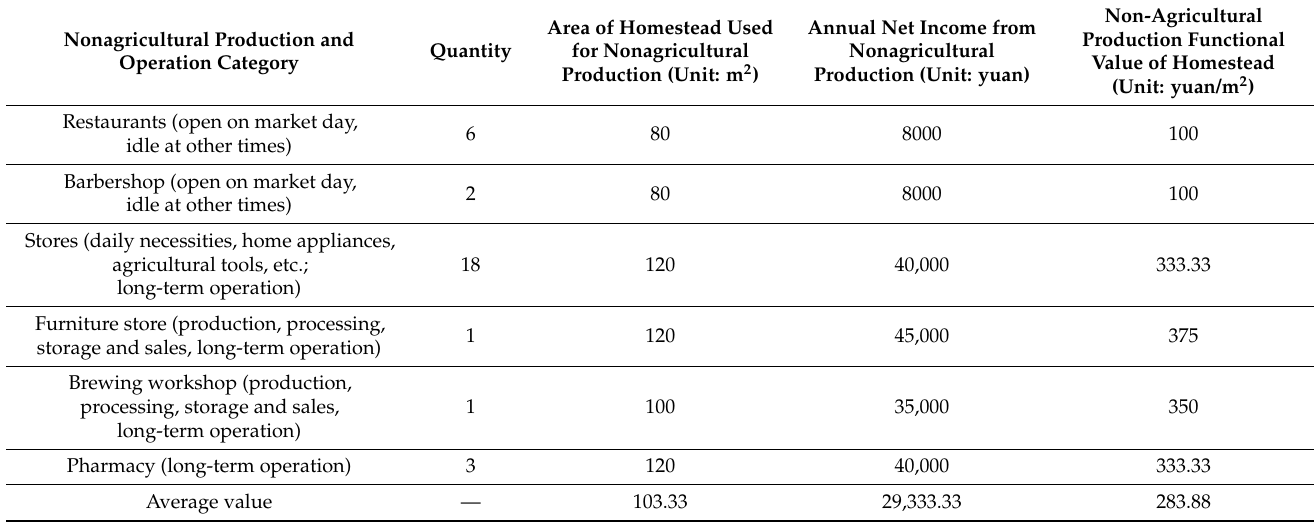
Table 1. Nonagricultural production and management categories and income of homesteads in Sujiaying